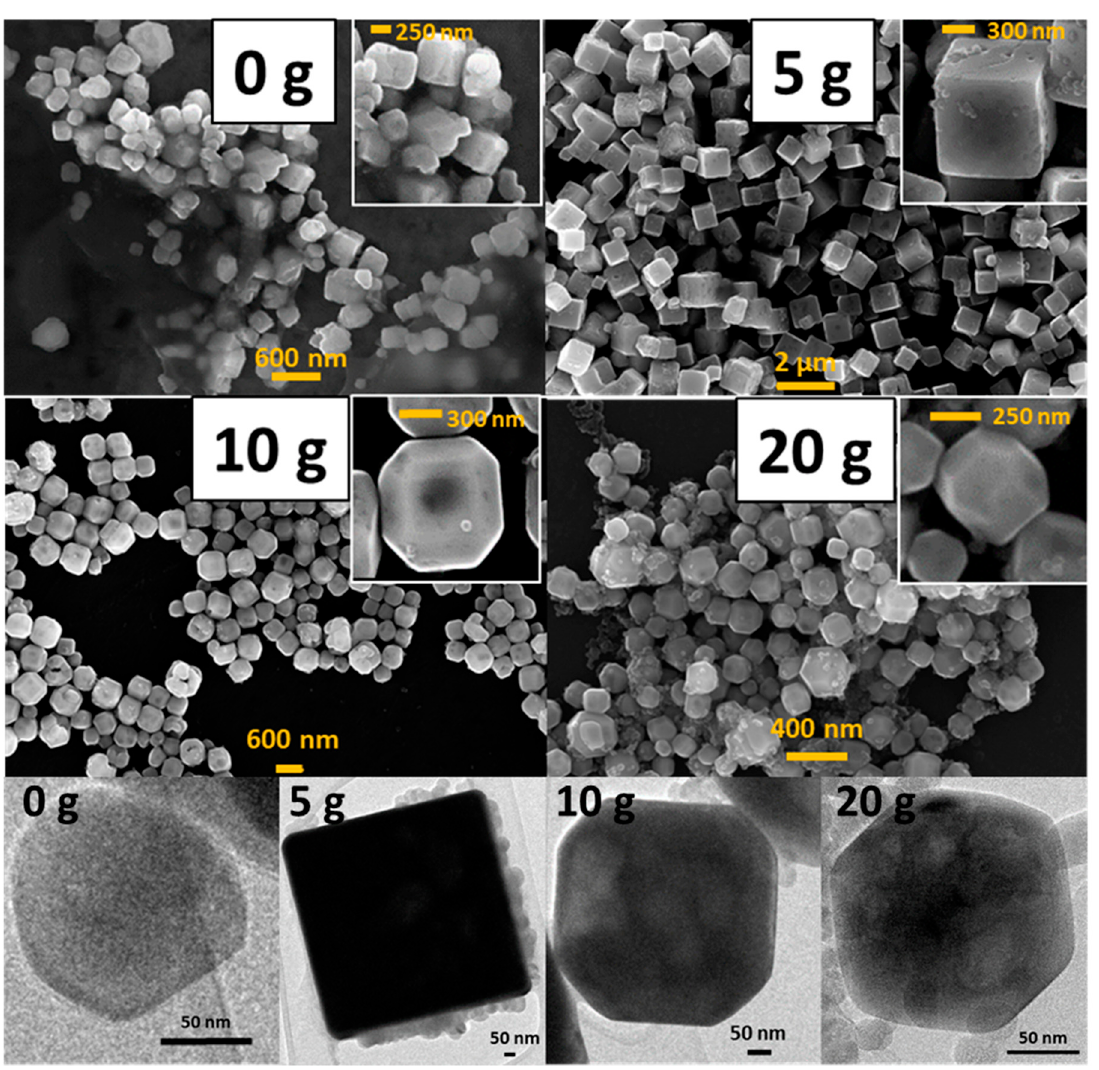
Figure 3. SEM (above) and TEM (below) micrographs of the four synthesized SrTiO 3 materials.